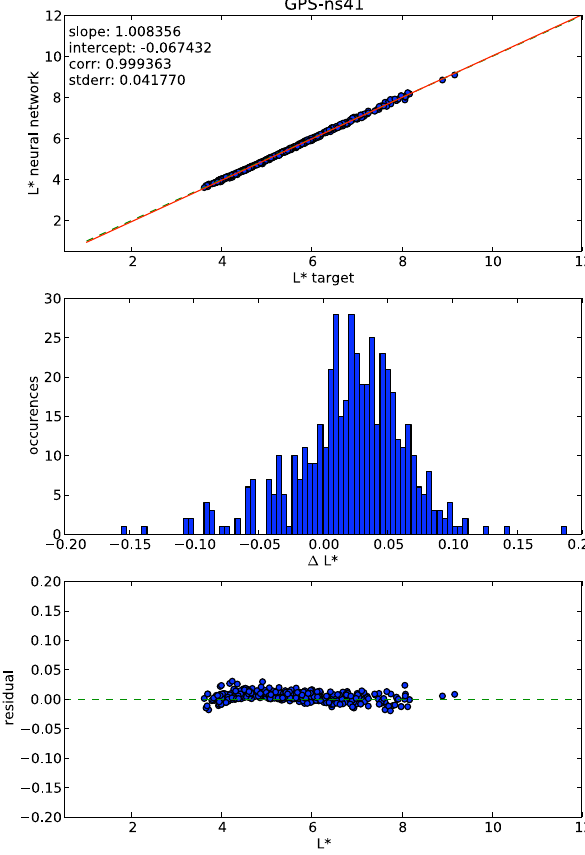
Fig. 2. Validation of neural network with CRRES satellite ephemerides. Top: scatter plot of L ∗ values from TS05 model (tar- get) against neural network results. Green-dashed line indicates a perfect fit and red solid line indicates the least-square fit to the scat- ter plot. One thousand ephemeris points and solar wind conditions were randomly chosen between 1 March 1991 and 1 April 1991 and include the geomagnetic superstorm on 24 March 1991 with Dst ≈− 300. Middle: histogram plot of overall residuals from scat- ter plot. Bottom: residual plot as a function of L ∗ .